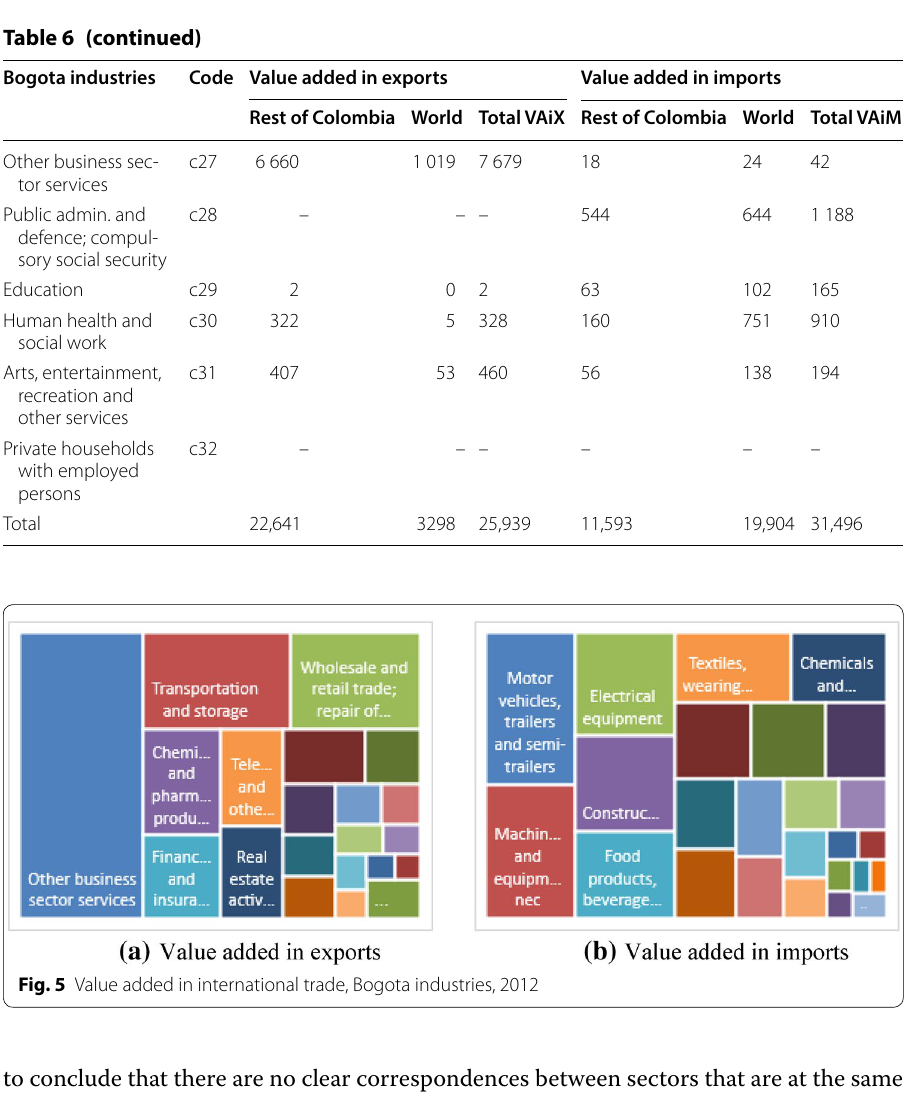
to conclude that there are no clear correspondences between sectors that are at the same time competitive (measured by their ability to generate value added in exports) and sec- tors that require a large amount of imports. In other words, contrary to what it is usually seen in sectors integrated to global value chains, Bogota’s industries do not “import to